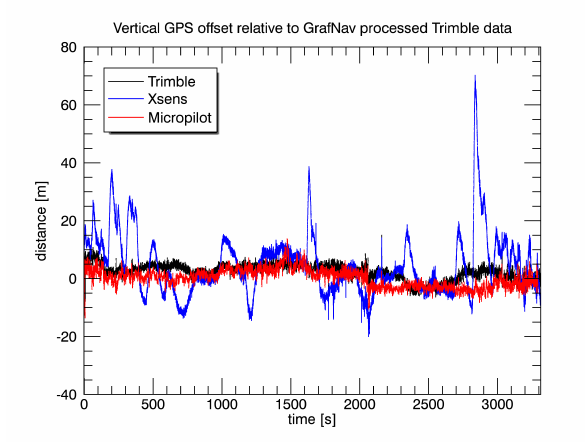
Figure 3: Vertical accuracy of different GPS receivers, compared to GrafNav post processed Trimble data. The time axis is in sec- onds from